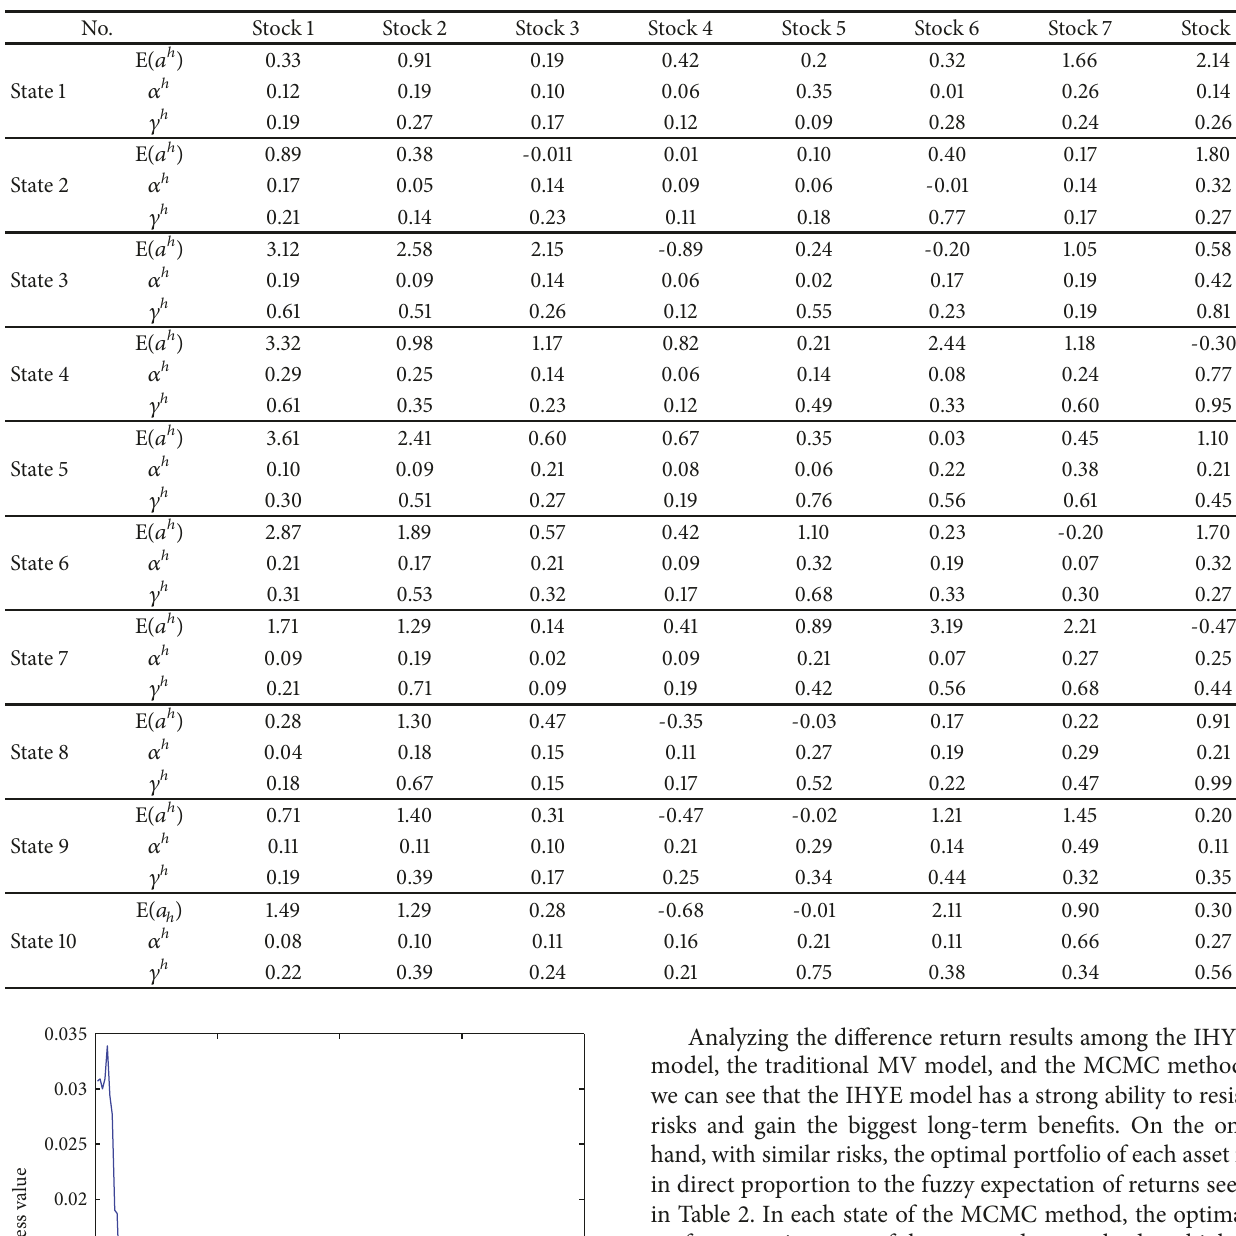
Table 1: The expectation rate and the right/left widths of 8 stocks under different states (%).